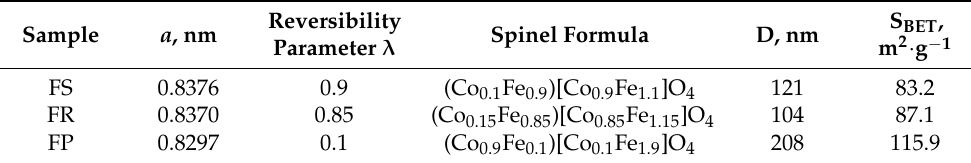
Figure 2. Distribution of cations over A- and B-positions of oxide spinel CoFe 2 O 4 for normal and reversed structures. Table 1. Characterization of synthesized composite materials.